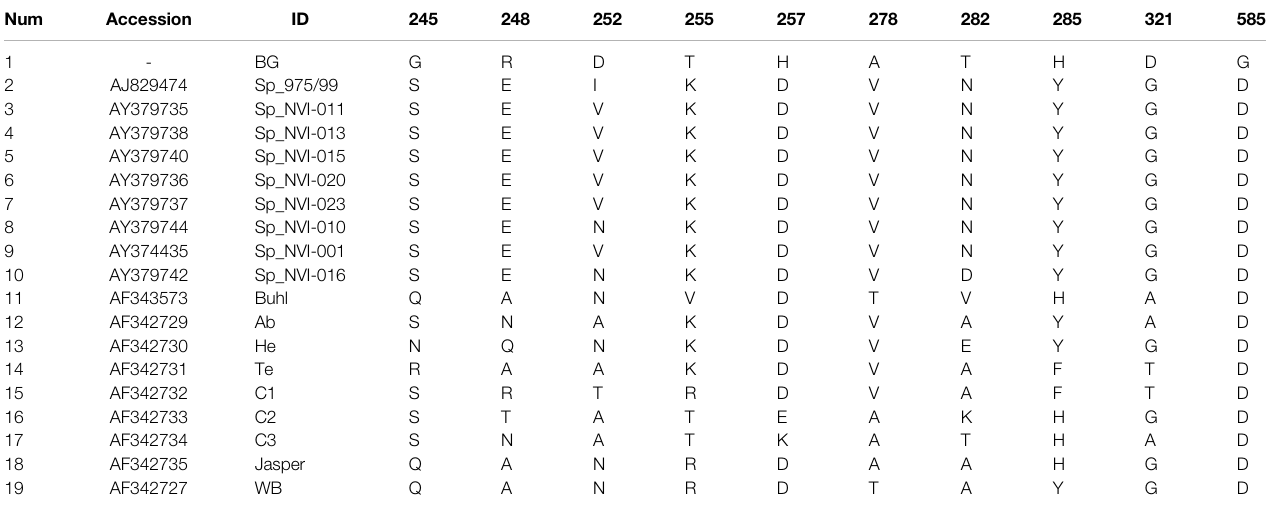
TABLE2| AminoacidresiduesandtheirpositionsinthepolyproteinregionoftheIPNVisolatesreportedinthisstudythatareeitherexclusivelyuniqueoroccurwithaverylow frequency in other